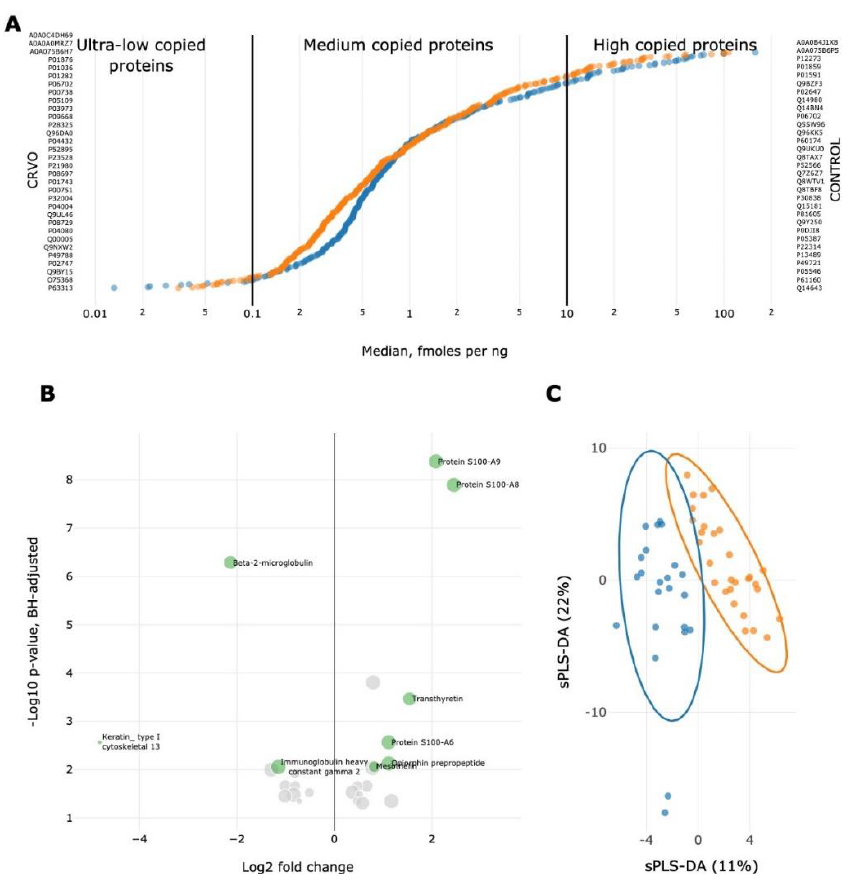
Figure 2. Distribution of protein quantitative properties in the combined proteome of control (orange color) and CRVO groups (blue color). The largest proportion (up to 78%) is covered by medium-copied proteins ranged between 0.1 − 10 fmoles/ng. The rest fraction can be split between low-copied (0.01 − 0.1 fmoles/ng) proteins (up to 8%) and high-copied (more than 10 fmoles/ng) proteins accounted up to 14% of the gathered tear proteome size. The listed proteins are ordered in a quantitative-dependent manner and arranged independently for the control (red color) and CRVO (blue color) groups ( A ). Volcano-plot scattering for 29 proteins (21 upregulated proteins (log 2 (FC) > 1) and 8 downregulated proteins (log 2 (FC) < − 1) with a frequency of more than 0.6 (92% of proteins be- longed to a frequency of 0.79 − 1.00) and significantly differed ( p < 0.05, Wilcoxon test with Benjamini– Hochberg correction) between the control group and subjects with CRVO. Proteins that fit the FC and p -value criteria are highlighted by green ( B ). The sPLS-DA scatter plot displayed co-variances of 11% and 22% between CRVO subjects (blue color) and healthy donors (orange color) using common fraction of proteome ( C